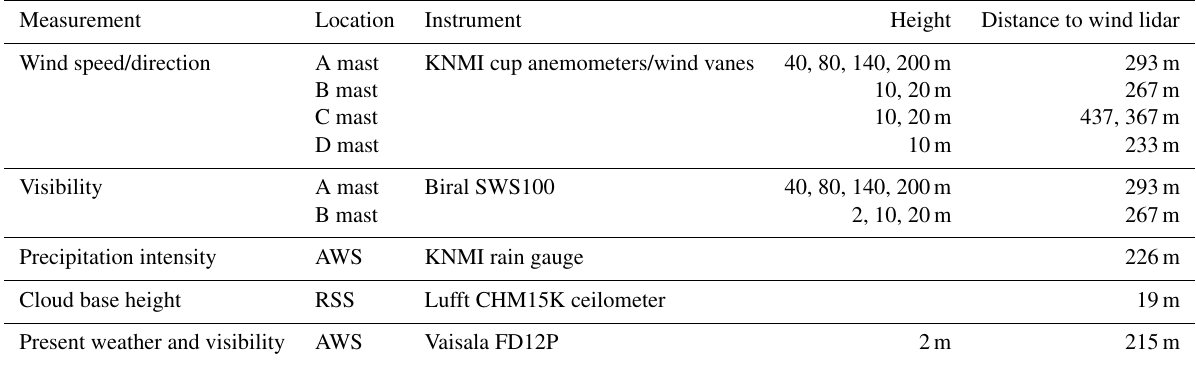
Table 2. Overview of other meteorological instruments used in this study (RSS: remote sensing site, AWS: automatic weather station), their locations are also indicated in Fig.